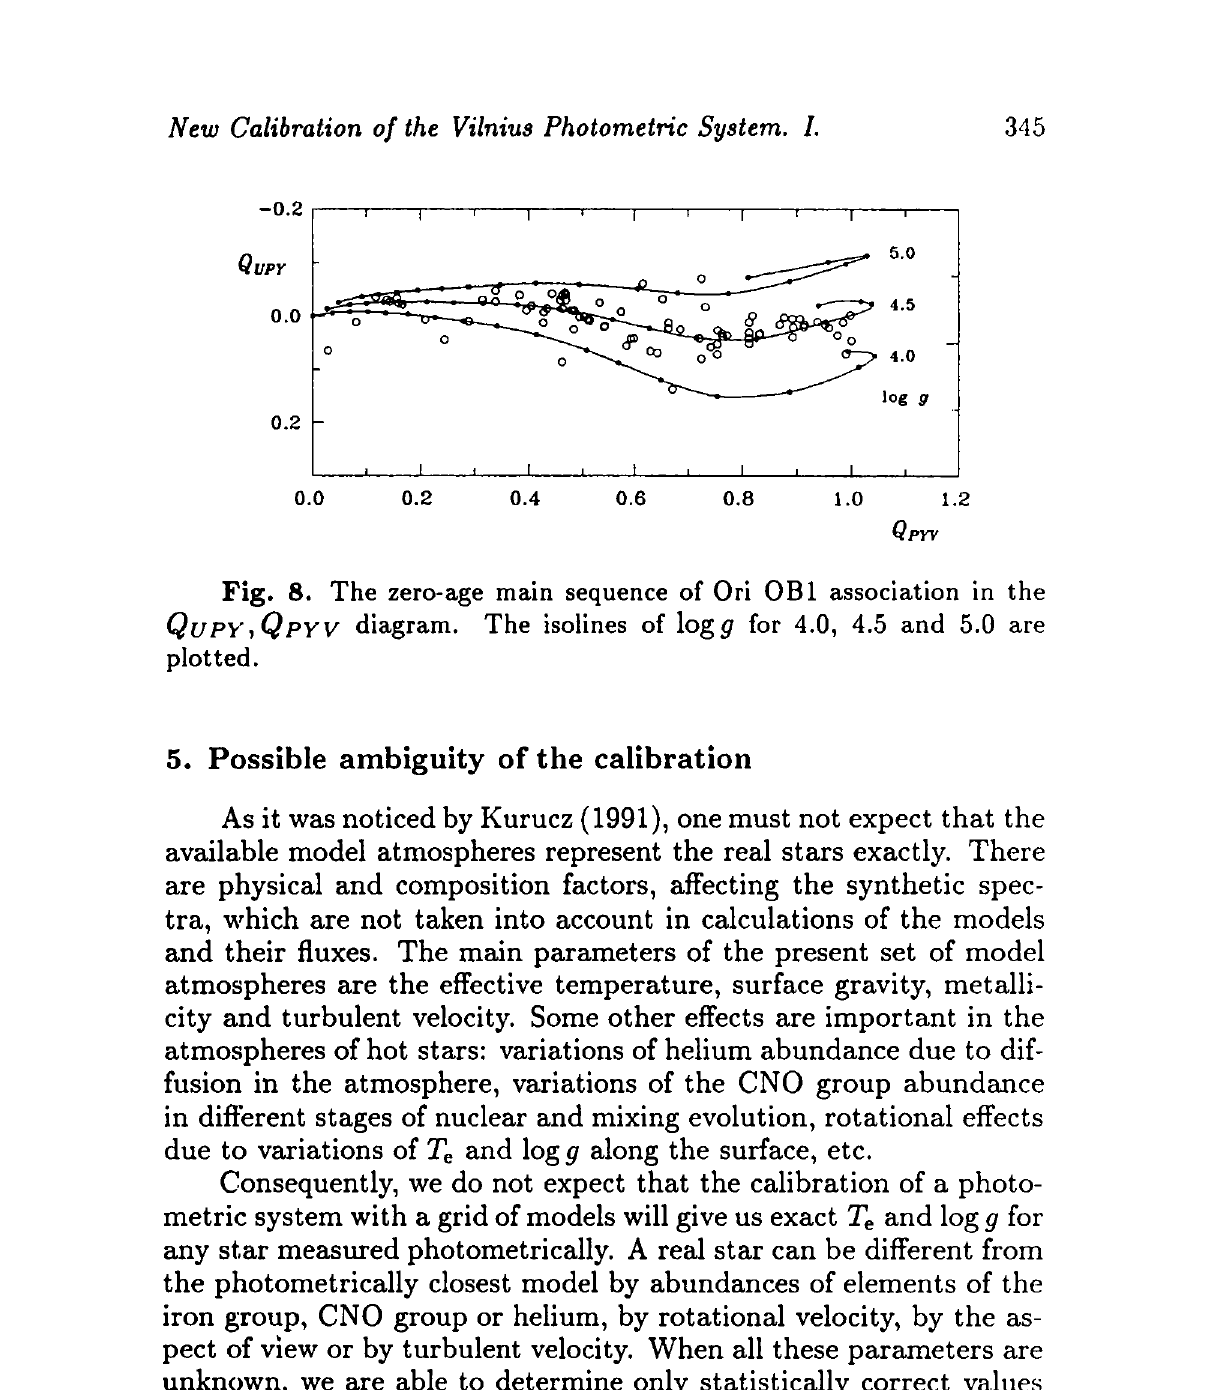
Fig. 8. The zero-age main sequence of Ori OBI association in the QuPY, QPYV diagram. The isolines of log <7 for 4.0, 4.5 and 5.0 are